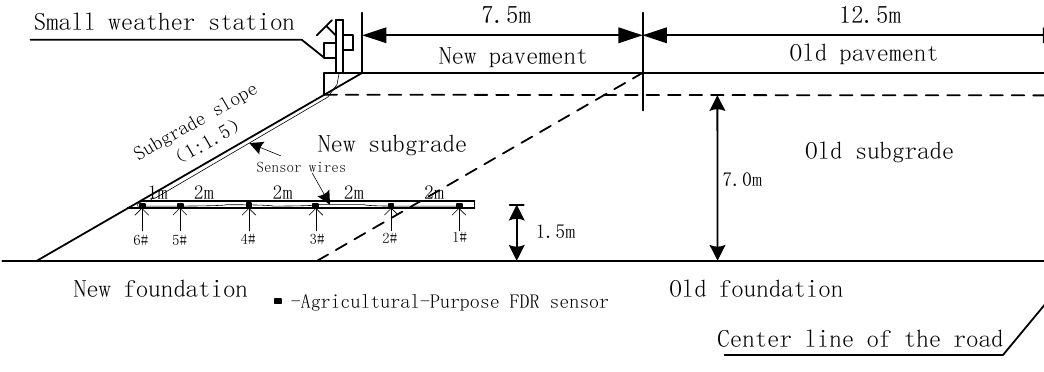
Figure 4. Small weather station (site picture). 3. Numerical Simulation Based on Measured Data Numerous factors influence the temperature and moisture of the soil mass inside the subgrade. The distributions of temperature and moisture of the subgrade soil are calculated assuming that the subgrade surface can be well drained and referencing the numerical calculation method for the